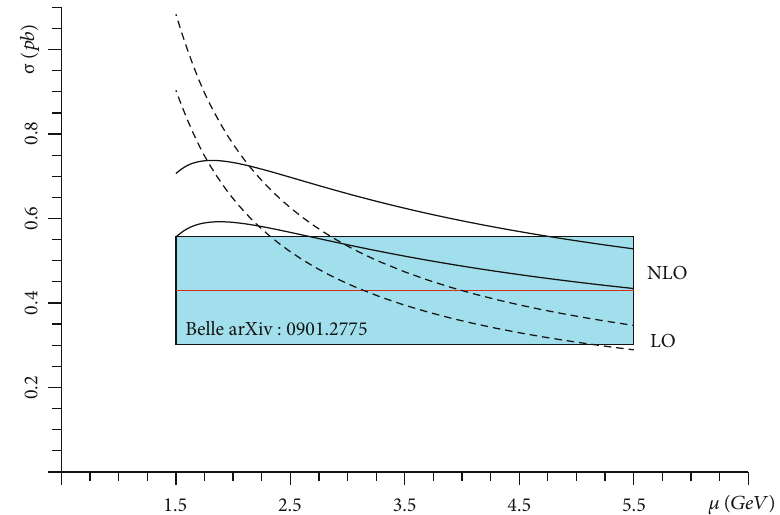
Figure 7: Prompt cross sections of e + e − ⟶ J / ψ + gg as functions of the renormalization scale μ at LO and NLO. The upper curves correspond to m = 1 : 4GeV , and the lower ones correspond to m = 1 : 5 GeV . Figure taken from Ref.